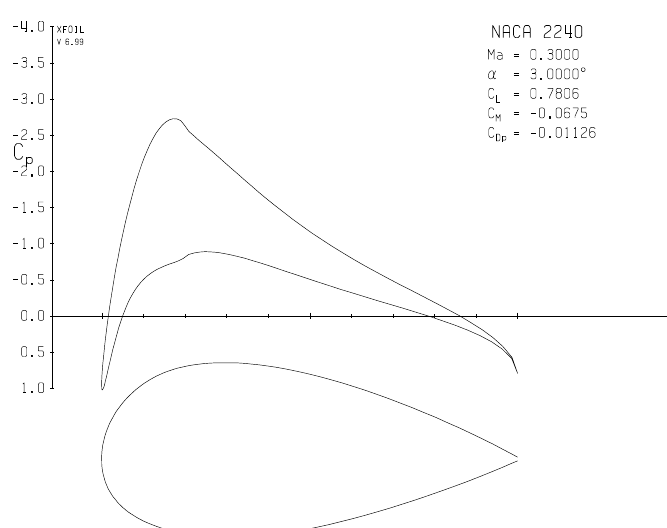
Figure 25. The airfoil surface pressure coe ffi cient distribution for NACA 2240 airfoil ( M ∞ = 0.3, α = 3 ◦ ) using XFOIL.